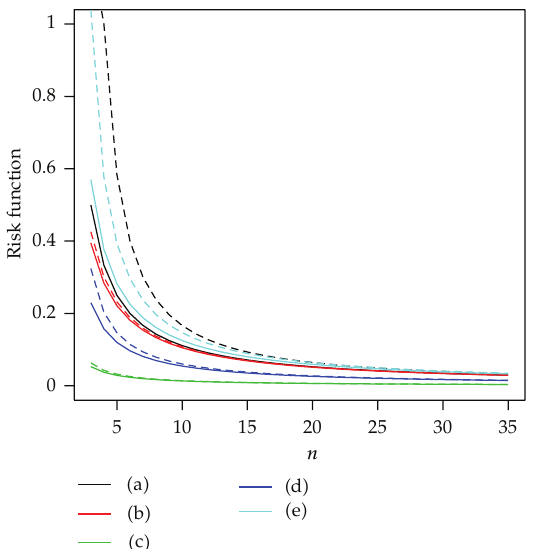
Figure 3: Risk function of estimators under the extended Je ff reys’ prior for di ff erent values of n with c 1 (cid:5) 0 .